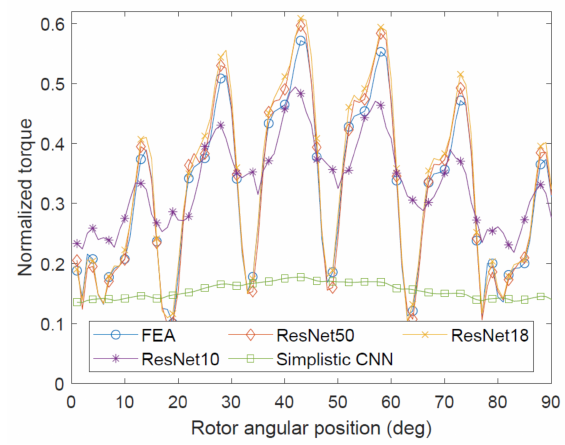
Figure 7. Example of CNN outputs in mid-torque region.